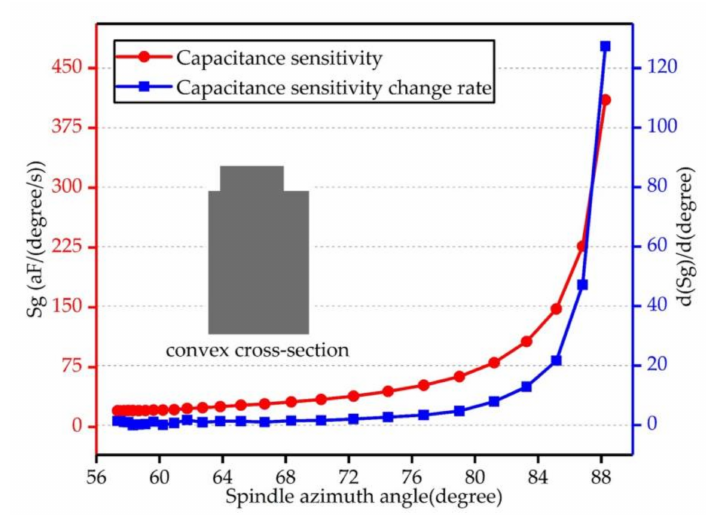
Figure 6. Capacitance sensitivity and rate of capacitance sensitivity change for the convex cross-section beam—the ultimate in-plane displacement of driving mode is fixed and the driving amplitude is maximal. This figure shows the maximum value of the capacitance sensitivity when the gyroscope has different spindle azimuth angles. The right vertical axis is the rate of capacitance sensitivity